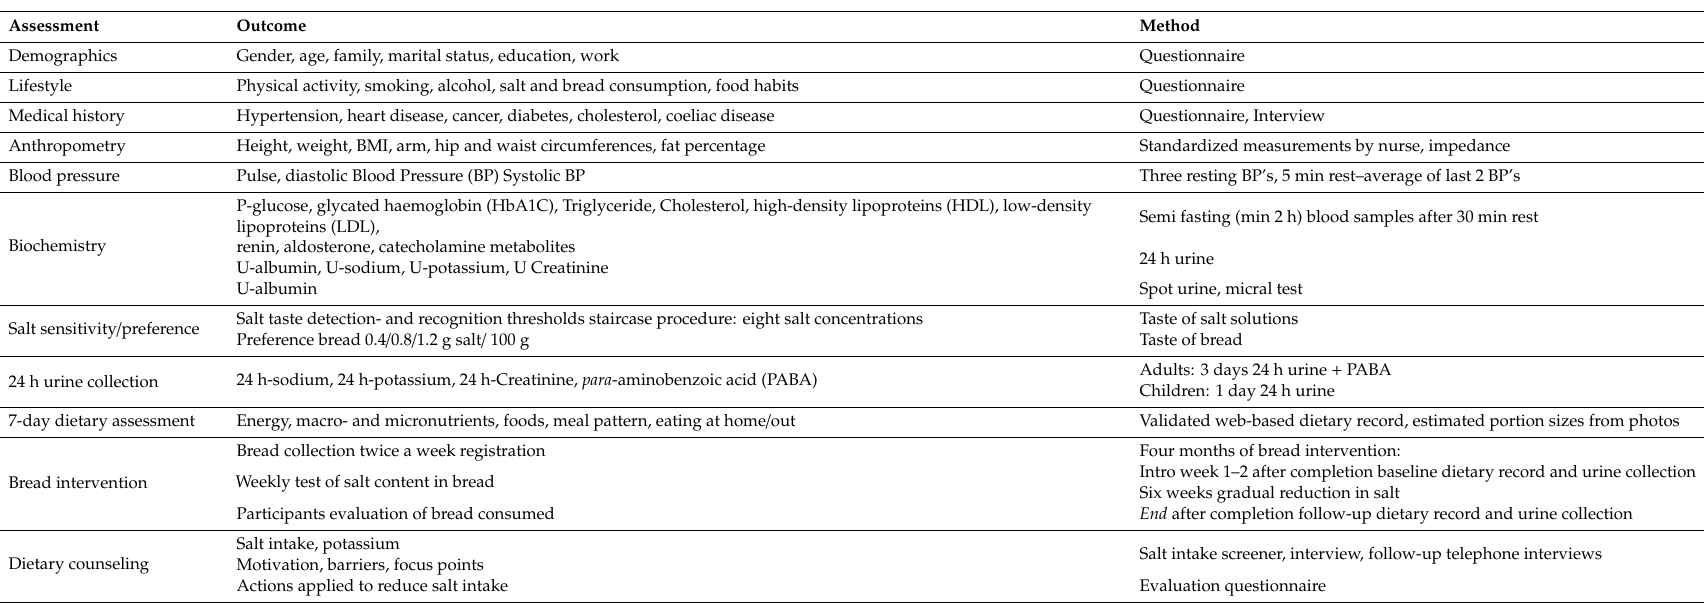
Table 3. Outcome variables and assessment